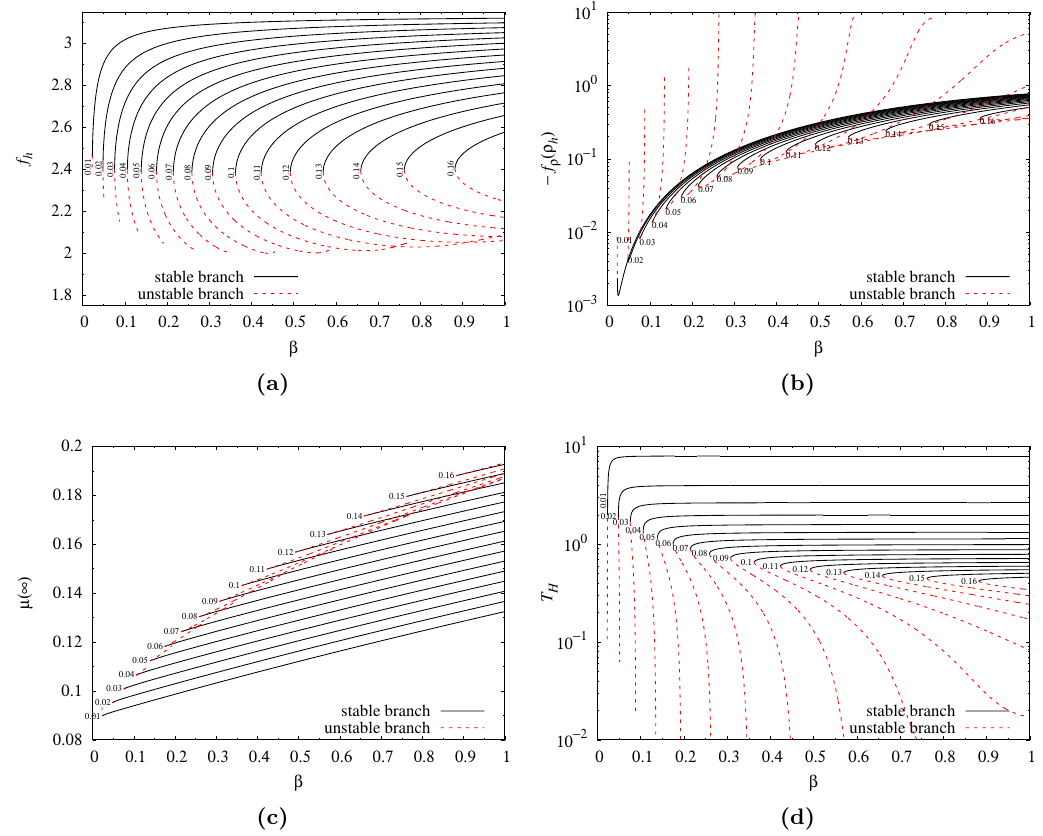
Figure 2 . Stable (black solid lines) and unstable (red dashed lines) branches of solutions in the 2 + 4 + 6 model: (a) the value of the pro(cid:12)le function at the horizon, f h ; (b) the derivative of the pro(cid:12)le function at the horizon, f (cid:26) ( (cid:26) h ); (c) the ADM mass, (cid:22) ( 1 ); (d) the Hawking temperature T H , all as functions of the Skyrme-term coe(cid:14)cient, (cid:12) . The numbers on the (cid:12)gures indicate the di(cid:11)erent values of (cid:26) h = 0 : 01 ; 0 : 02 ; : : : ; 0 :